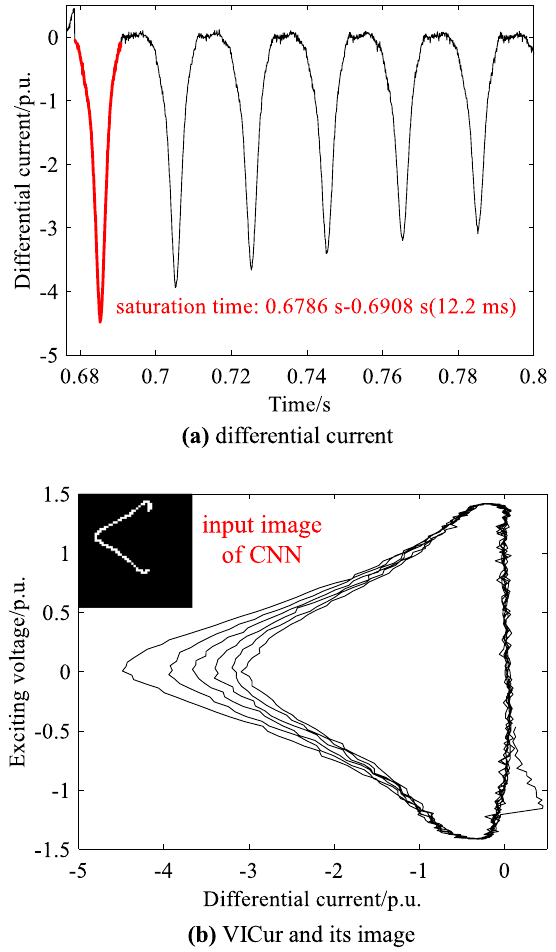
Fig. 11 An example of healthy transformer identified